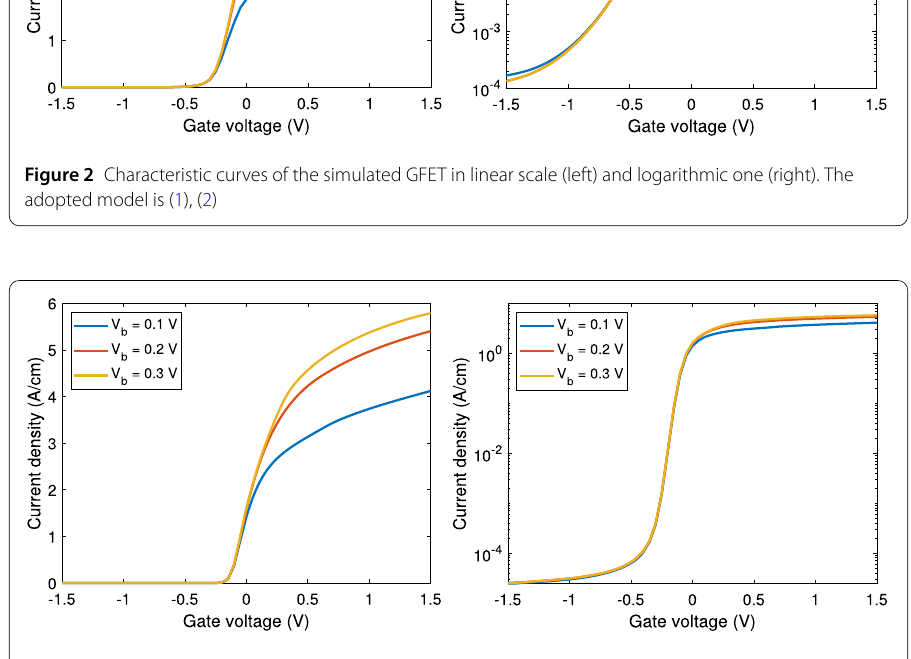
Figure 3 Characteristic curves of the simulated GFET in linear scale (left) and logarithmic one (right). The adopted model is (1), (4)